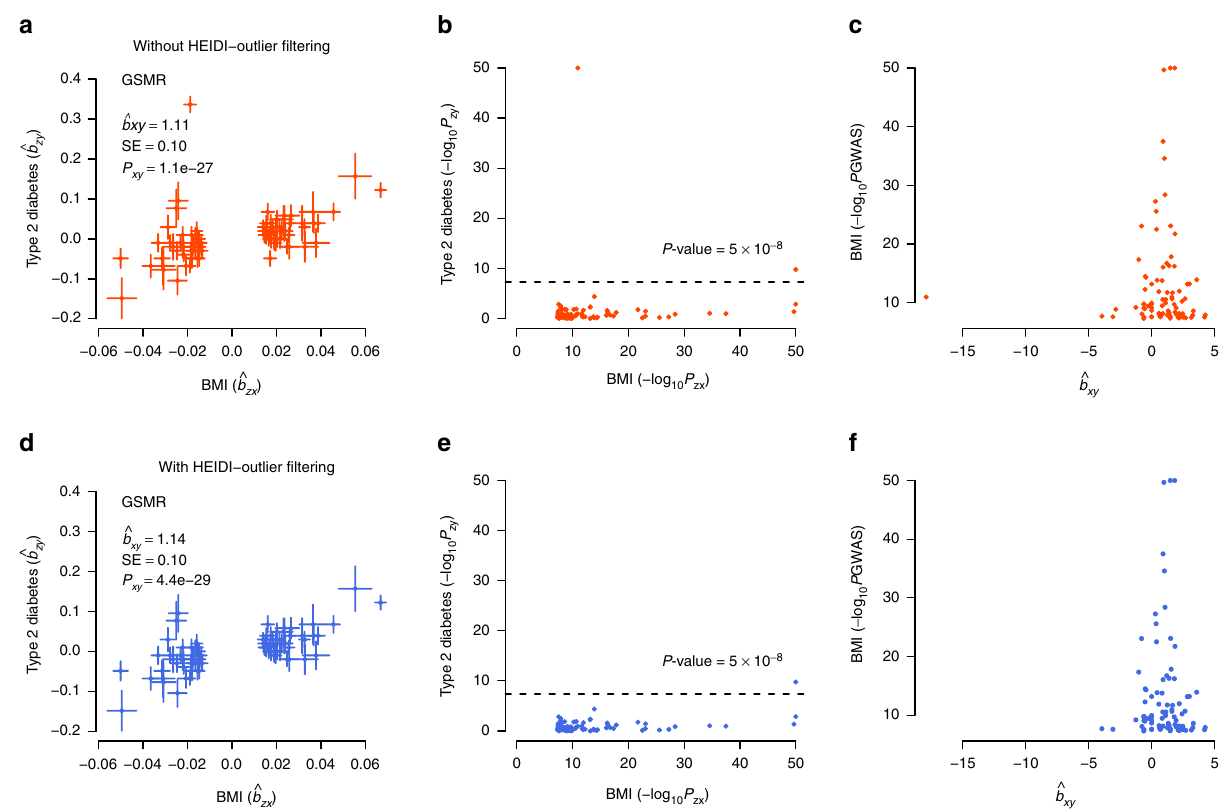
Fig. 3 GSMR analysis to test for the effect of BMI on T2D with and without fi ltering the pleiotropic outliers. Shown in a and b are the plots of effect sizes and association P -values of all the genetic instruments from GWAS for BMI vs. those for T2D. Shown in c is the plot of b xy vs. GWAS P -value of BMI at each genetic variant. Shown in d , e , and f are the plots for the instruments after the pleiotropic outliers being removed by the HEIDI-outlier approach (see Methods for details of the HEIDI-outlier approach). Error bars in a and d represent the standard errors. The dashed lines in b and e represent the GWAS threshold P -value of 5 × 10 − 8 . The coordinates in b , c , e , and f are truncated at 50 for better graphic